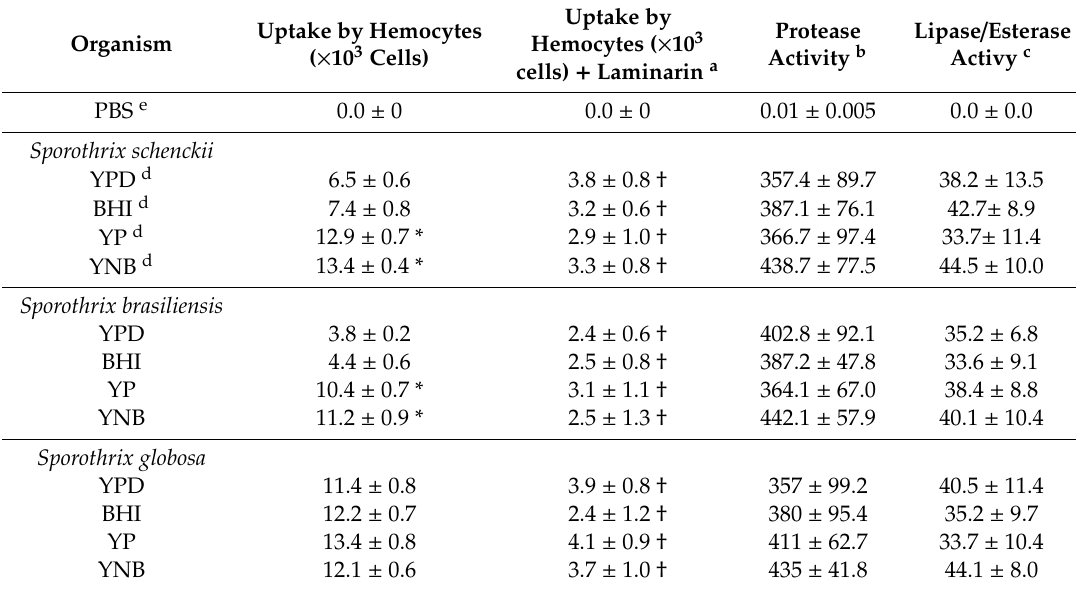
Table 2. Analysis of secreted protease and lipase / esterase activity and uptake by hemocytes of Sporothrix schenckii , Sporothrix brasiliensis , and Sporothrix globosa grown in di ff erent culture